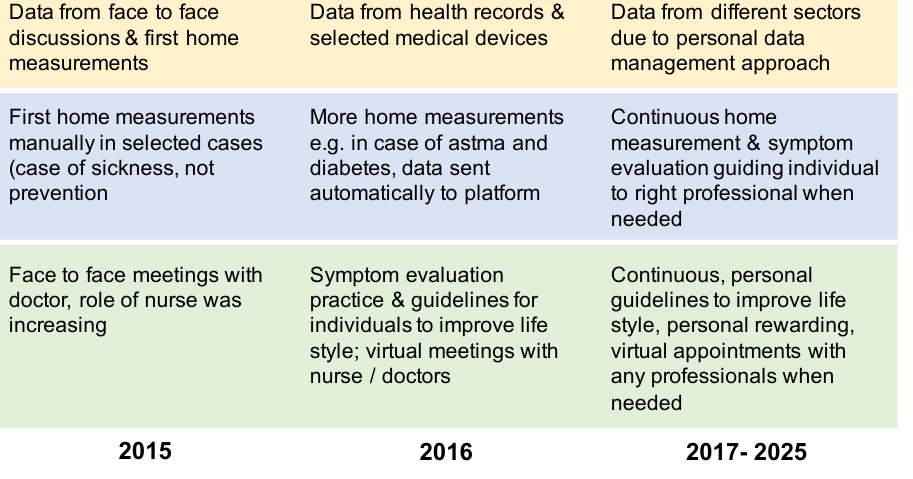
Fig. 2. Data impact on practices — finding the right health professionals and using the